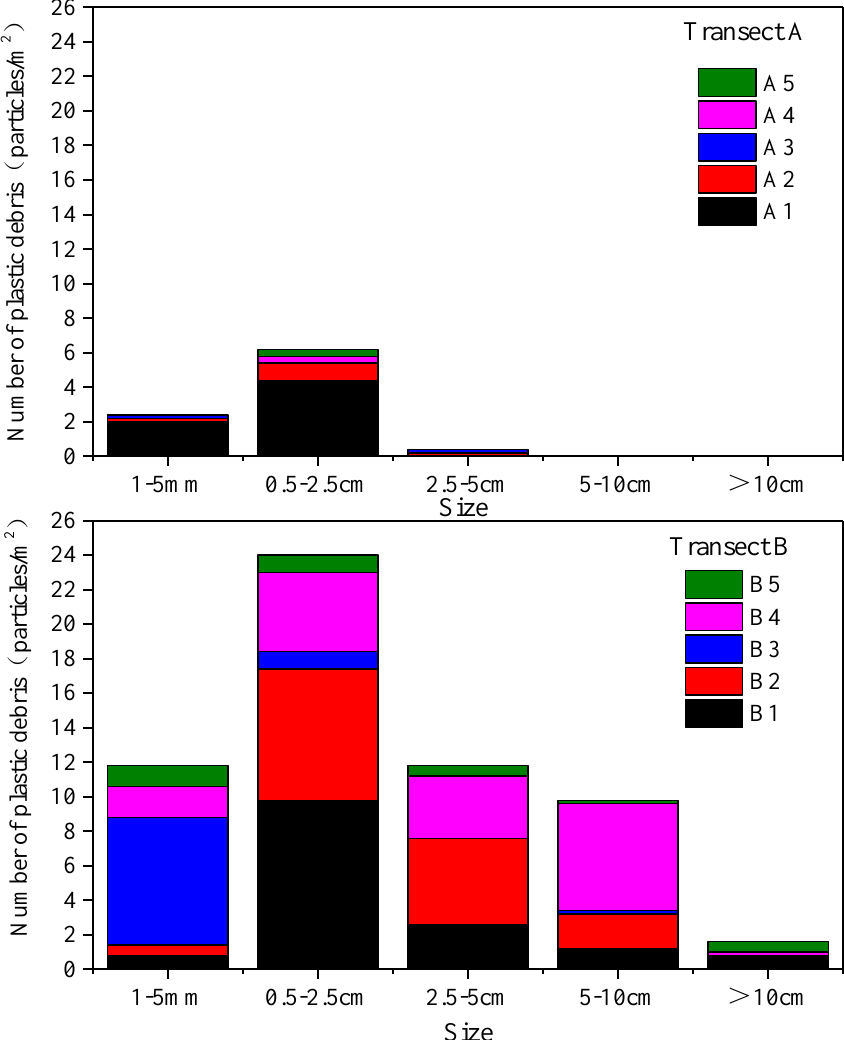
Figure 4. Amount of plastic debris size along the land-based source wastewater in the two transects.